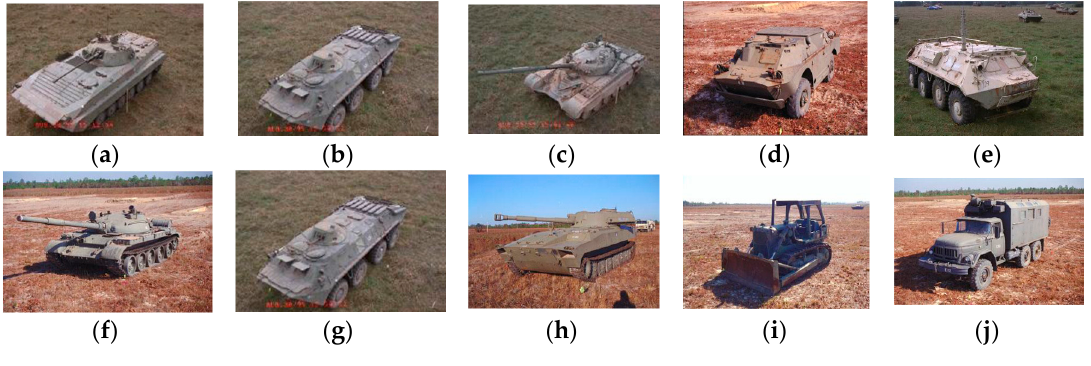
Figure 6. The optical images of ten military targets in MSTAR dataset. ( a ) BMP2-C21; ( b ) BTR70; ( c )